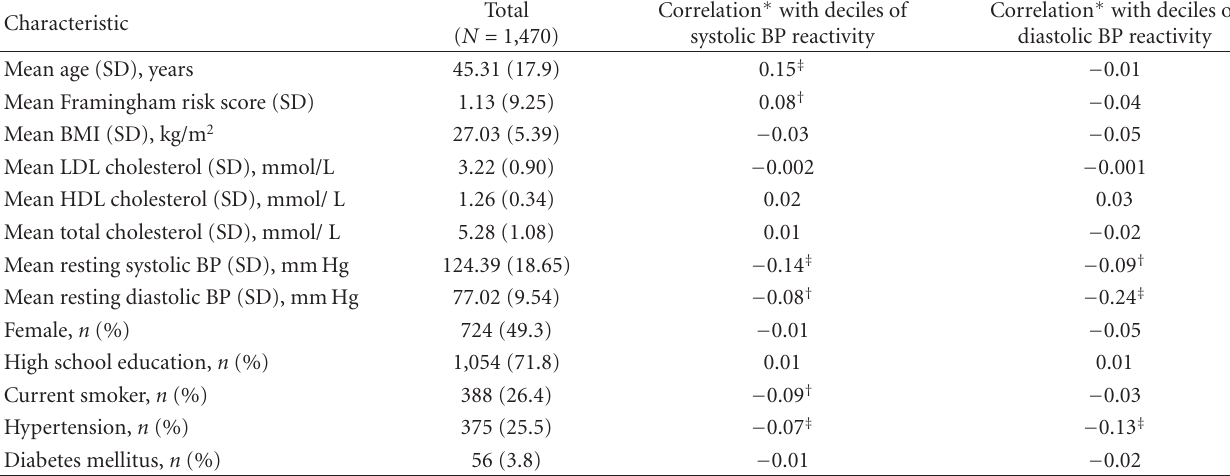
Table 1: Baseline characteristics of 1,470 NSHS95 participants and their correlation with systolic and diastolic blood pressure reactivity to an anger provocation